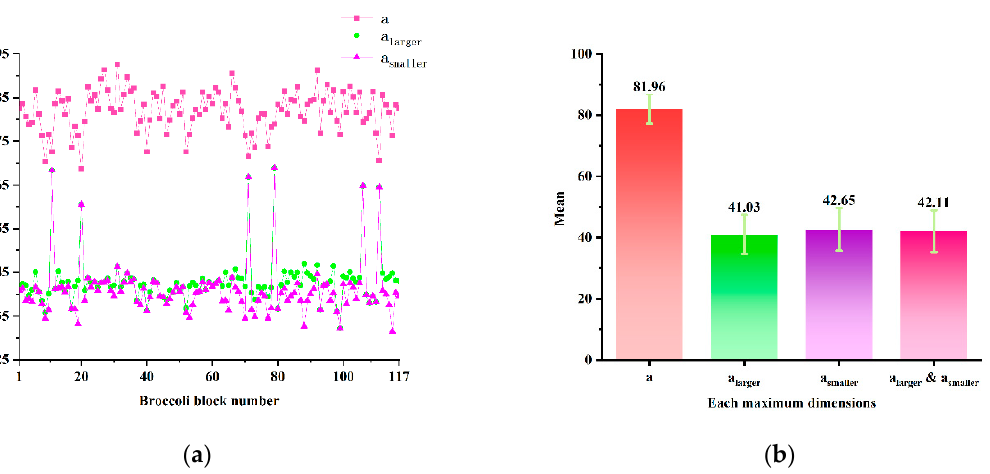
Figure 21. Comparison diagram of the maximum size of broccoli block: ( a ) Maximum size of each block after two cuts; ( b ) Average value and error of the maximum size of the block after two cuts. Table 2. Comparison of block-cutting efficiency and success rate of different equipment.